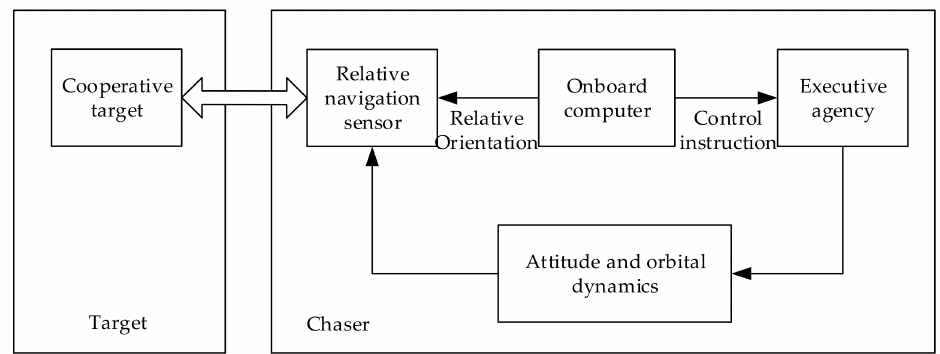
Figure 1. Autonomous rendezvous and docking